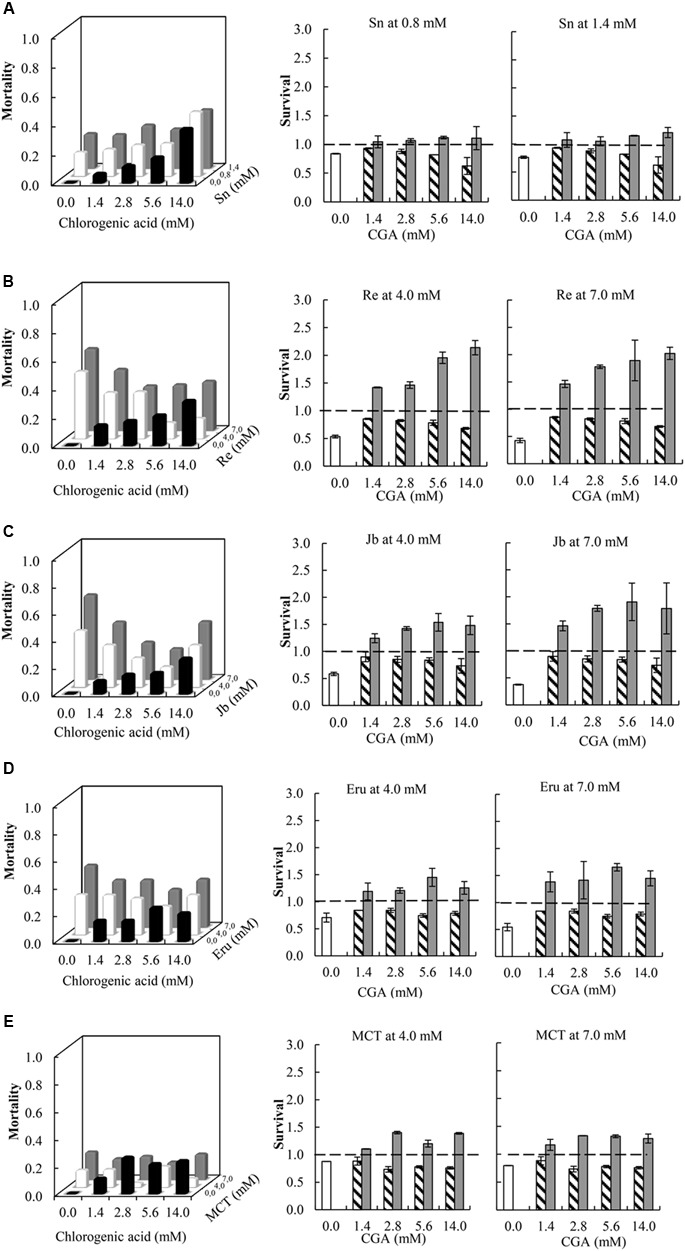
Left: Fraction mortality (1- fraction survival) of 2nd instar thrips larvae (Frankliniella occidentalis) caused by the single metabolites and the combination of CGA with senecionine (A), retrorsine (B), jacobine (C), erucifoline (D), and monocrotaline (E). Right: Fraction survival (mean ± 95% confidence intervals) of thrips caused by PA alone (white bars), CGA alone at four concentrations (hatched bars), and the interaction effect SX∗Y (Equation 4) between PAs and CGA (gray bars). In the left figures, the fraction mortality was plotted to increase the readability of the figure. In the right figures, dashed line indicates a thrips survival fraction of one. Deviation of the interaction effect SX∗Y from the dashed line (survival = 1) indicates synergistic (<1) or antagonistic effect (>1). Two-way ANOVAs were used to analyze whether the overall interaction effect SX∗Y deviated from one (Table 1). Sn, senecionine; Re, retrorsine; Jb, jacobine; Eru, erucifoline; MCT, monocrotaline.